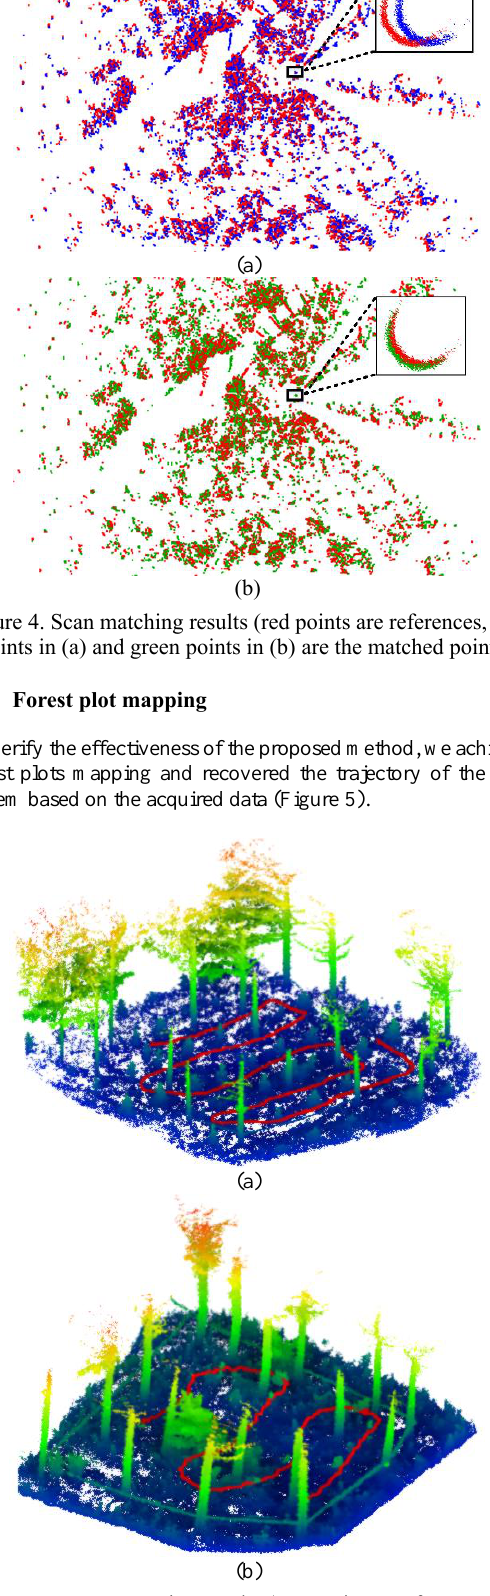
Figure 5. Forest mapping results (grey points are forest points and red curves are the trajectories). (a) is the mapping result of Plot A, and (b) is the result of Plot